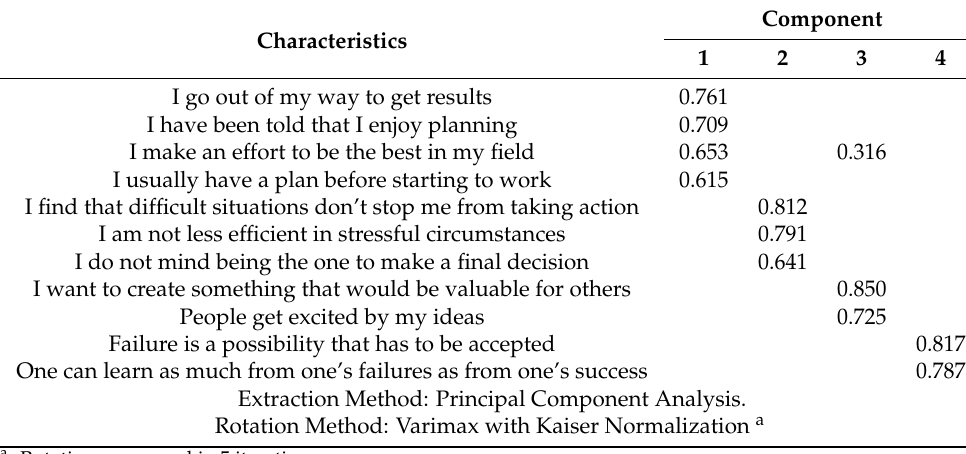
Table 3. Rotated component matrix of Entrepreneurial characteristics.